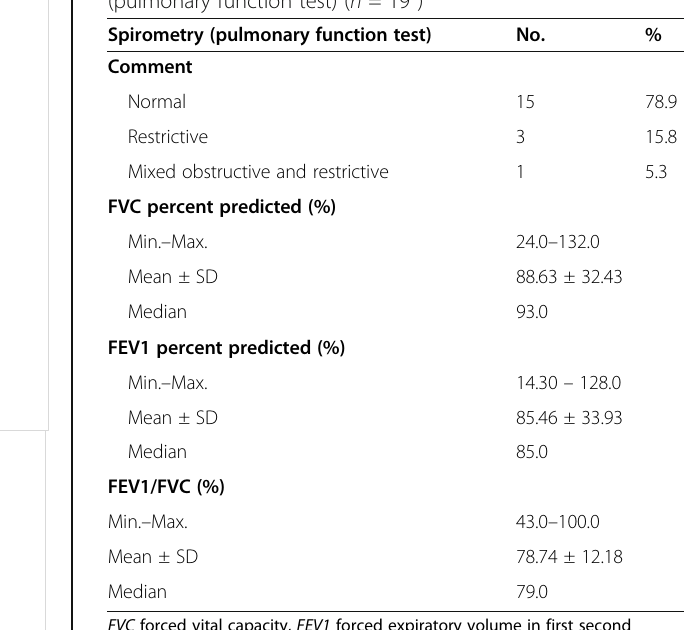
Table 4 Interpretation of spirometry in studied patients